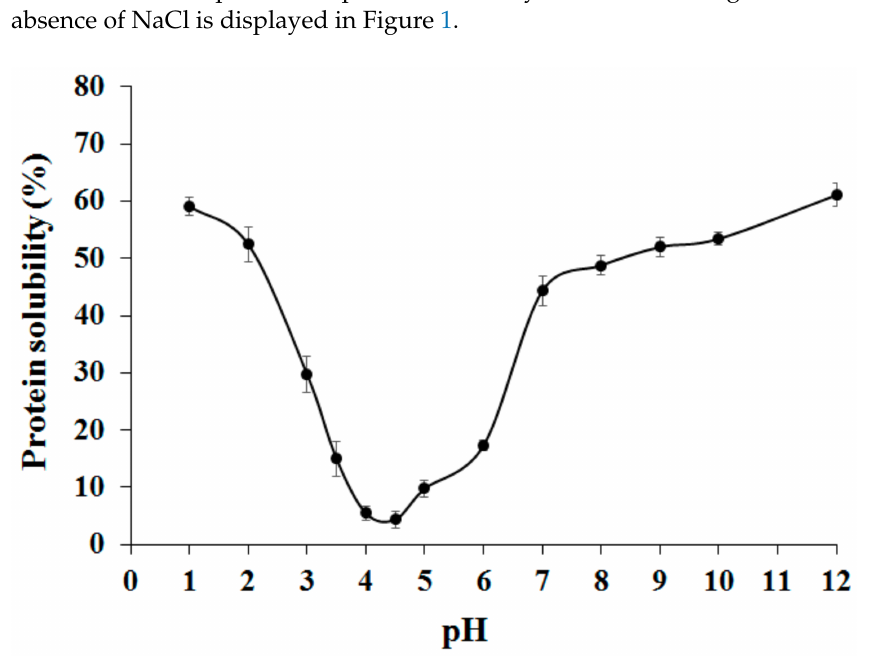
Figure 1. Effect of pH on adzuki bean globulins